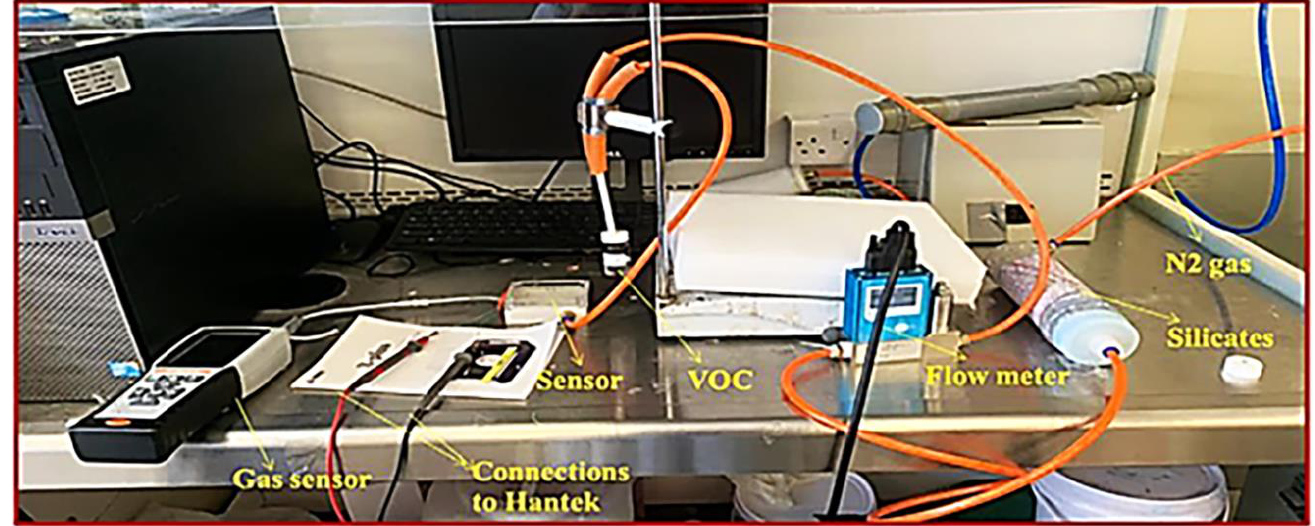
Figure 7. Schematic diagram of volatile organic compound (VOC) gas sensing setup [161]. Repro- duced with permission from Wiley.